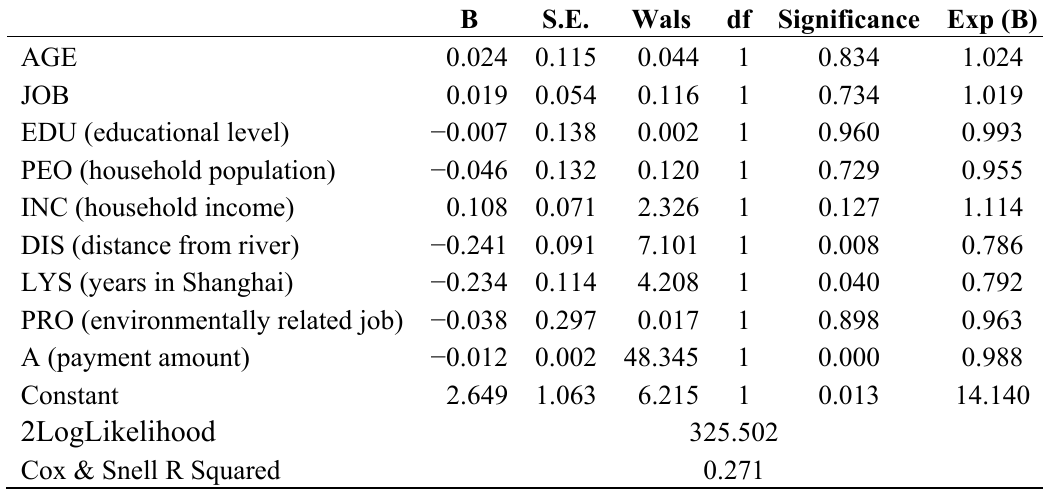
Table 4. Results from binary logistic regression (WTP > 0, N = 373).